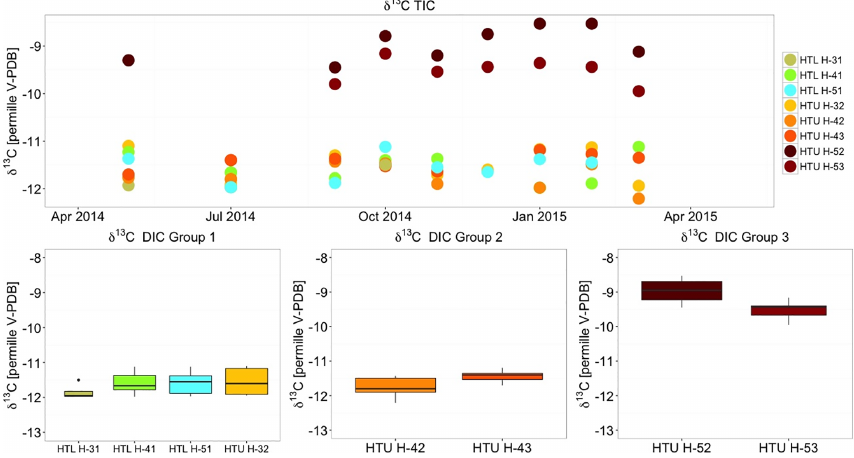
Figure 2. Stable isotope monitoring of δ 13 C DIC . Upper part: δ 13 C DIC values show minor temporal but strong spatial variations. According to results from δ 13 C DIC and 14 C DIC and DIC concentrations, wells can be divided into three groups (boxplots in the lower part). Group 1 comprises all oxic wells of HTL and well H-32 of HTU, which is also oxic. Groups 2 and 3 are the anoxic wells of HTU in locations H-4 and H-5, respectively.